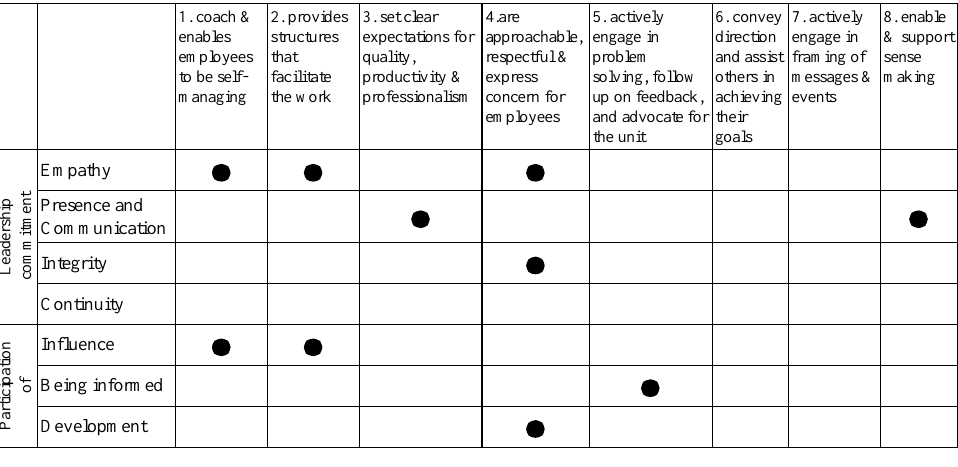
Table 3 – Comparison of health related Quality Management dimensions versus key principles of Communicative